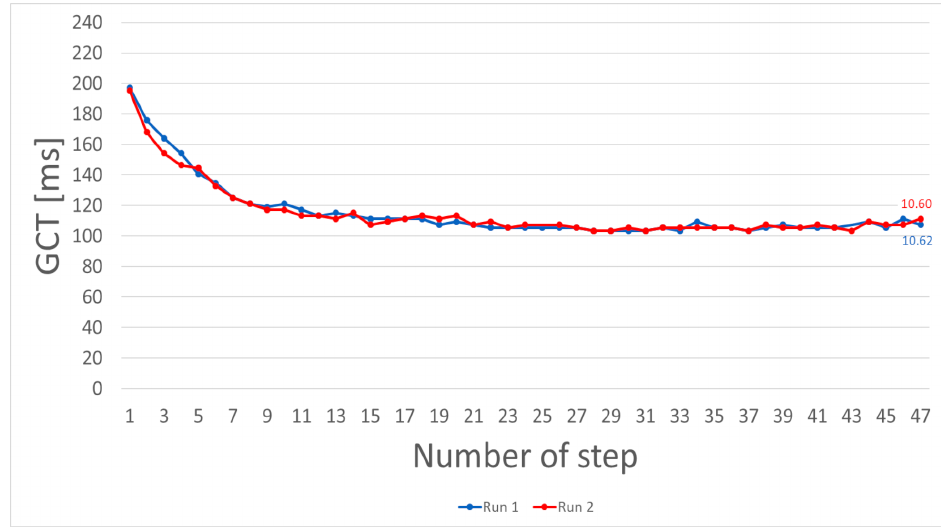
Figure 5. IMU-measured GCT of two 100 m sprints of the same athlete. Run 1 (blue) was conducted approximately 30 min before Run 2 (red). The graph illustrates reliable intra-subject